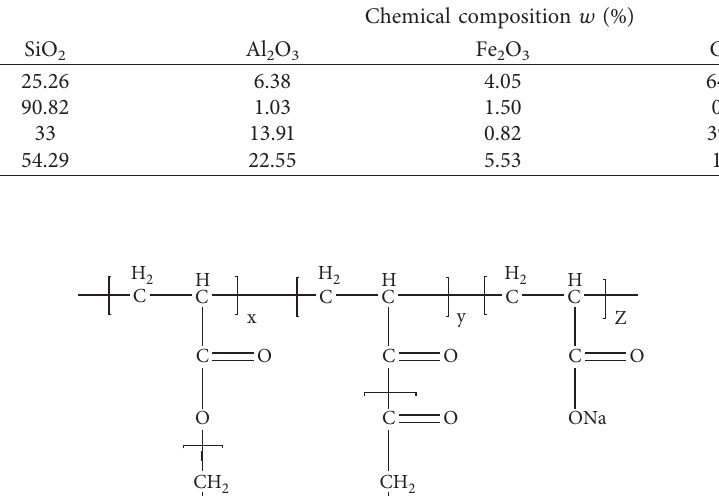
Table 1: Chemical composition of PI 42.5 Portland cement, slag, fly ash, and silica fume w (%).